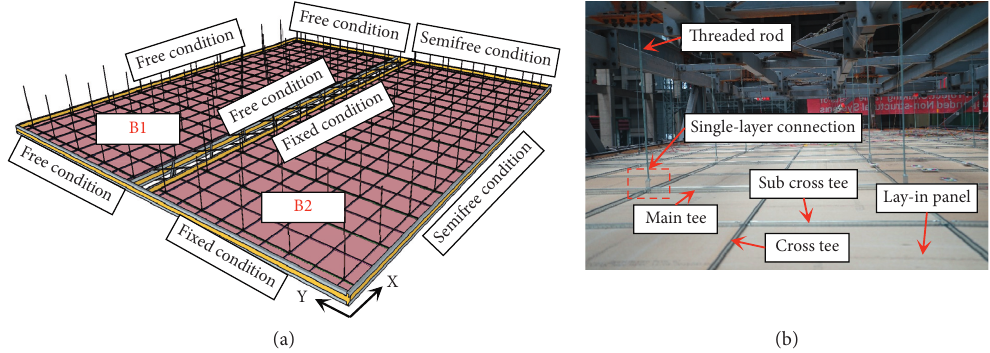
Figure 5: Test specimen. (a) Overall view of the specimen and (b) photo of the specimen.